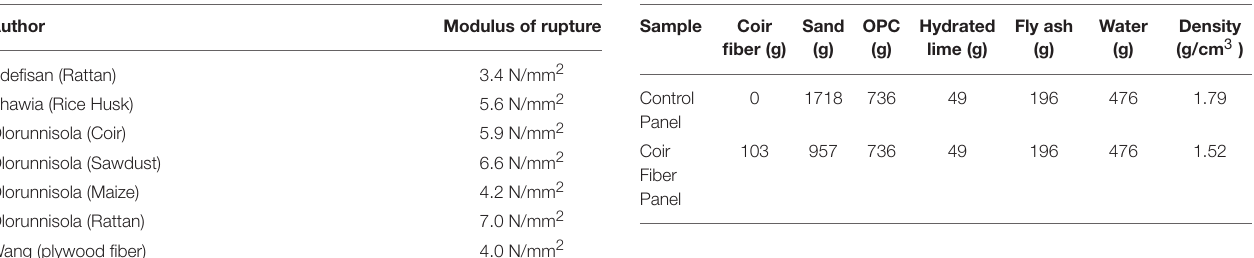
TABLE 1 | Comparison of Published MoR Results. TABLE 2 | Mixture by weight for control and coir fiber panel